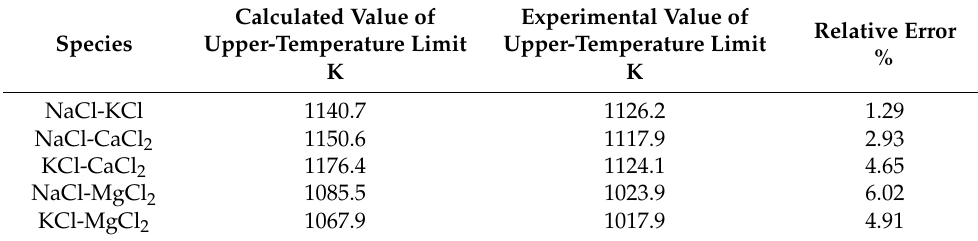
Figure 22. Weight change (wt.%) of the NaCl-KCl binary chloride salt. Table 10. Calculated and experimental value of the upper-temperature limit of the binary chlo- ride